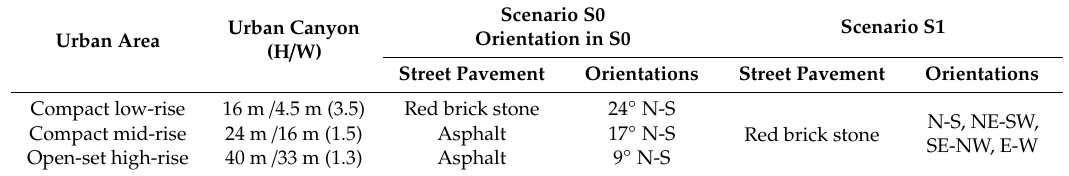
Table 9. Settings of the scenarios to study the e ff ect of orientation (S0) and street’s pavement (S1).